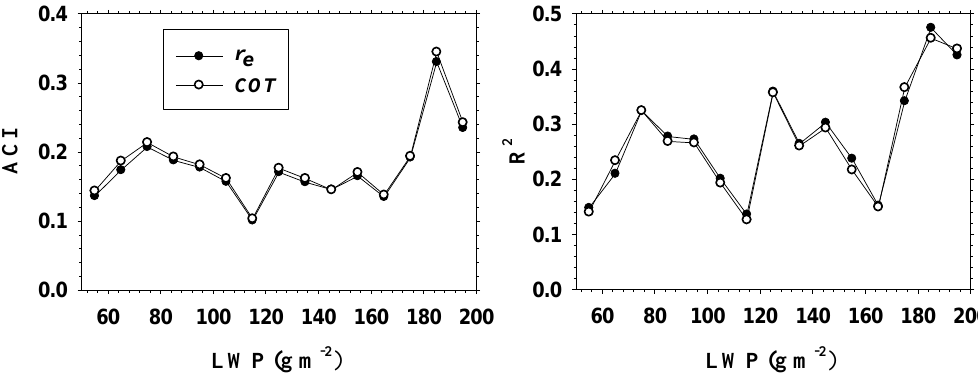
Fig. 4. On the left Aerosol-cloud interaction (ACI) from a combination of remote sensing cloud properties and in situ measures of aerosol burden as a function of Liquid Water Path (LWP) measured by satellite. On the right: Correlation coefficient ( R 2 ) between cloud and aerosol parameters as a function of LWP. ACI is calculated with concentration of particles larger than 130 nm.